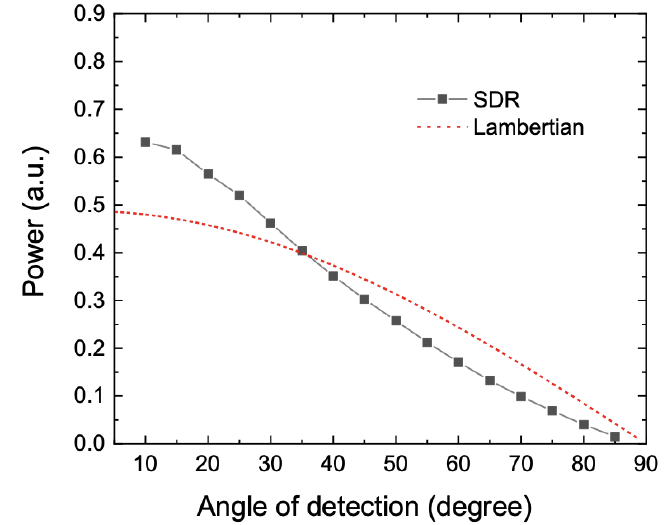
Figure 8. Measured bidirectional reflectance distribution function (BRDF) of the standard diffuse reflector (SDR) at 2 µm wavelength with the same reflection characteristics as the integrating sphere inner wall (ISW).